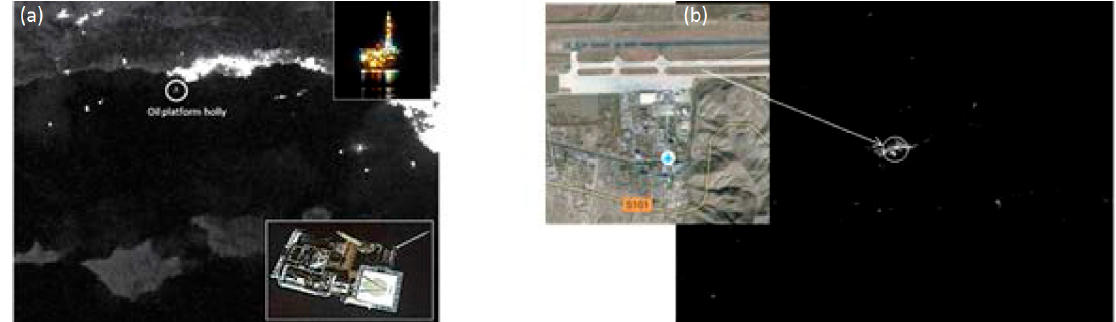
Figure 8. Two DNB nighttime point sources: ( a ) the Oil Platform Holly; ( b ) the Lhasa airport.